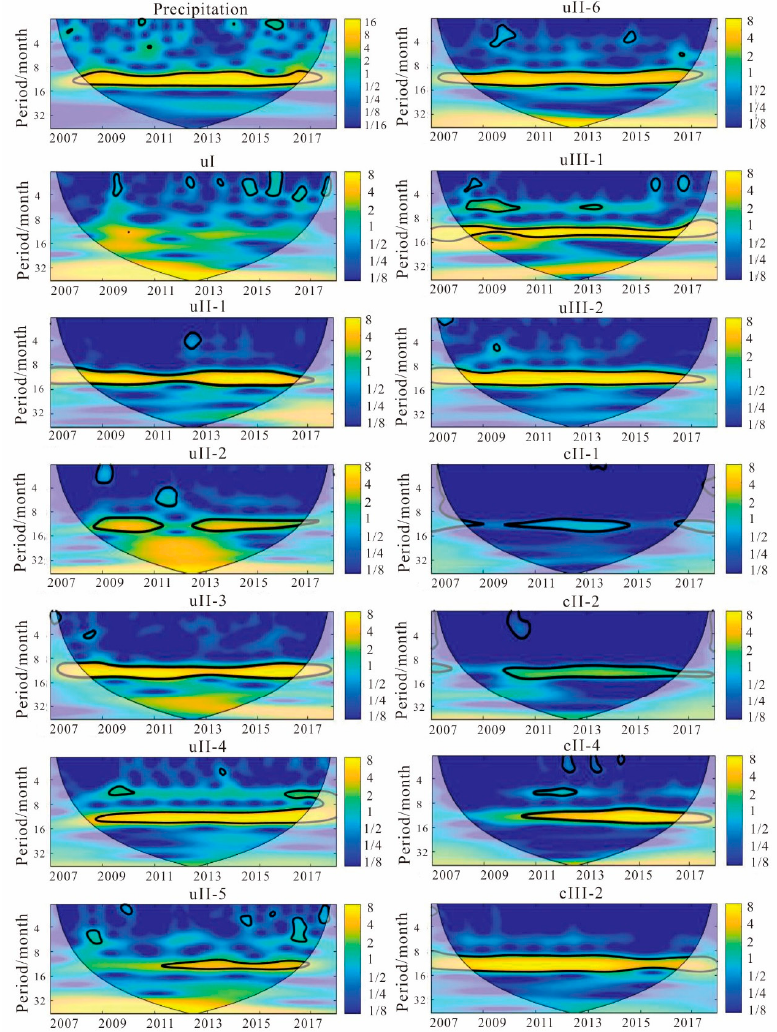
Figure 12. CWT (Continuous Wavelet Transform) analysis of precipitation and groundwater depth in di ff erent hydrogeological zones. Yellow and blue represent the peaks and valleys of the energy density, respectively, reflecting the local and dynamic characteristics of the time–frequency conversion of the dominant fluctuation component. The color shade indicates the relative change in energy density. The closed value of the black thick solid coil passed the red noise test at the 95% confidence level. The cone area below the black thin solid line is the wavelet influence cone (COI) area, and it is the area where the edge effects of the continuous wavelet transform data were more affected. The precipitation subgraph shows the result of CWT analysis on the precipitation of UPABC. The uI, uII-1, uII-2, uII-3, uII-4, uII-5, uII-6, uIII-1, and uIII-2 subgraphs show the results of CWT analysis on the groundwater depth of the unconfined aquifer in the I, II-1, II-2, II-3, II-4, II-5, II-6, III-1, and III-2 hydrogeological zones defined in Figure 2a. The cII-1, cII-2, cII-4, and cIII-2 subgraphs show the results of CWT analysis on the groundwater depth of the confined aquifer in the II-1, II-2, II-4, and III-2 hydrogeological zones defined in Figure precipitation in the UPABC, and it passed the 95% red noise test from 2008 to 2016 and had a